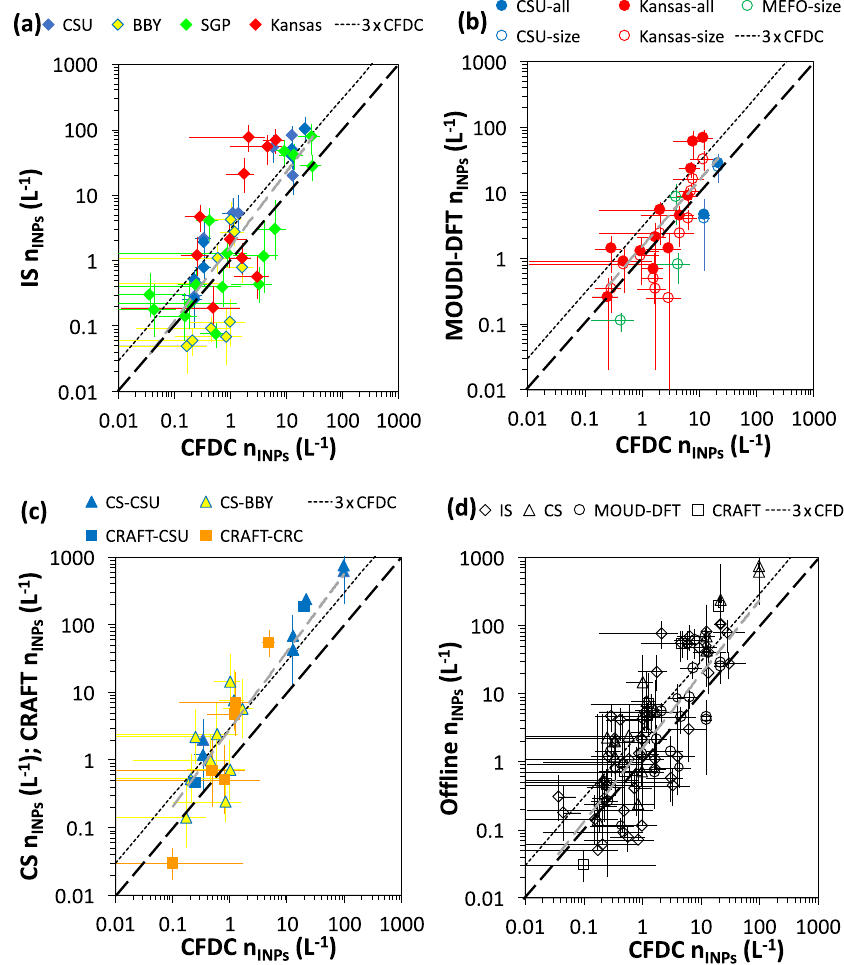
Figure 3. Scatterplot of INP number concentrations obtained with different immersion freezing methods plotted against CFDC online mea- surement results obtained at 105% RH and temperatures ranging from approximately − 15 to − 31 ◦ C: (a) IS, (b) MOUDI-DFT (medians of data such as shown in Fig. 1), (c) CS and CRAFT, (d) all data combined from offline immersion freezing tests. The MOUDI-DFT data in (b) include data for all particles sizes assessed (“all”) and for the particle size range of 0.3–3.2µm (“size”) best aligned with the effective CFDC sampling size range. Error bars represent 95% confidence intervals, as defined for each method. Light dashed gray lines are simple linear relations intended only to guide the